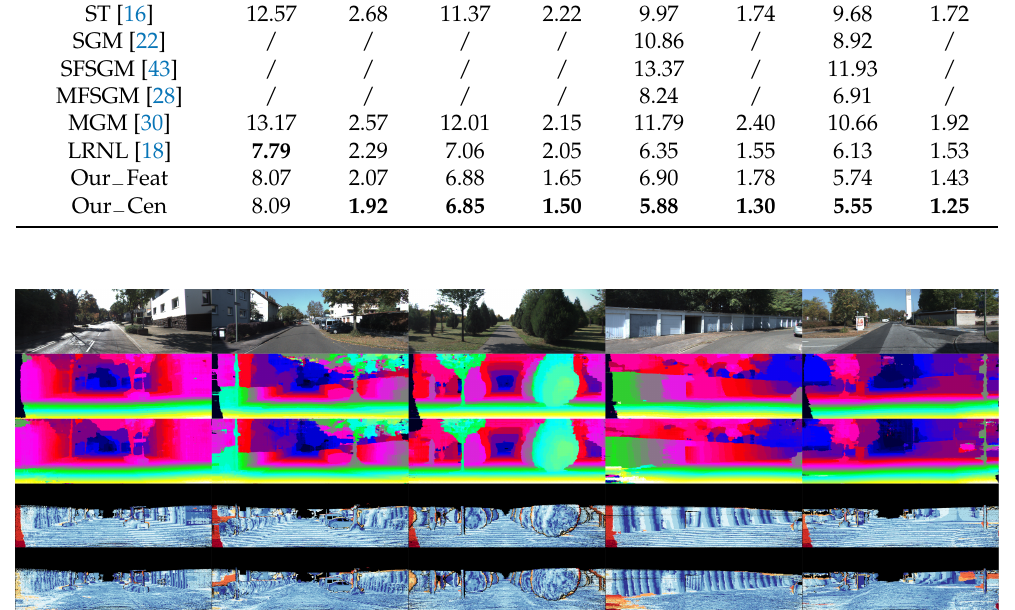
Figure 8. Some results of our method for testing images in KITTI 2012 dataset [37]. Images from top to bottom: reference image, disparity image based on feature maps extracted by CNN and handcrafted feature, error maps of corresponding disparity images.